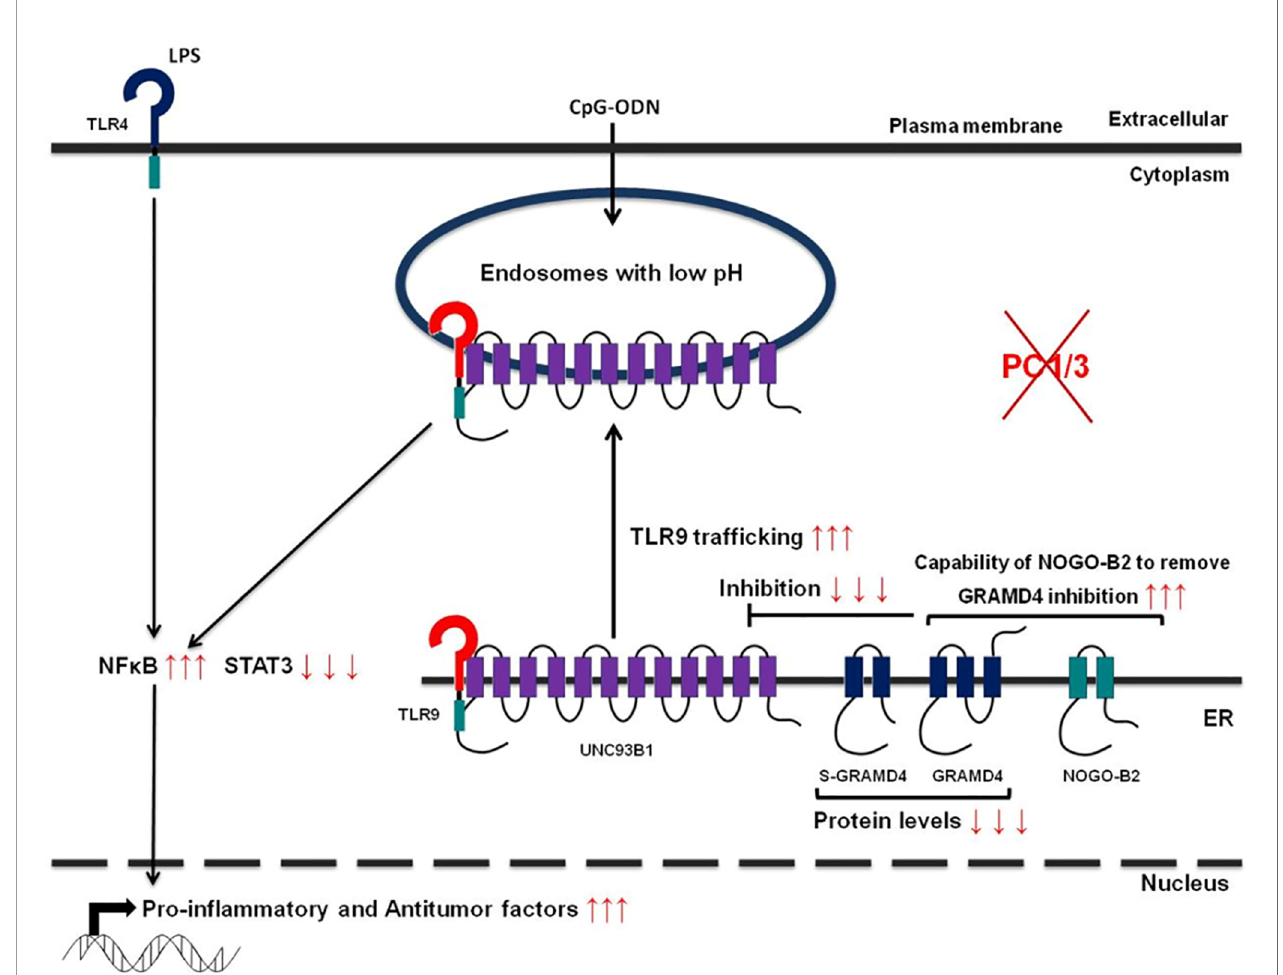
FIGURE 4 | Schematic depicting how PC1/3 knockdown impacts TLR4 and 9 activation in